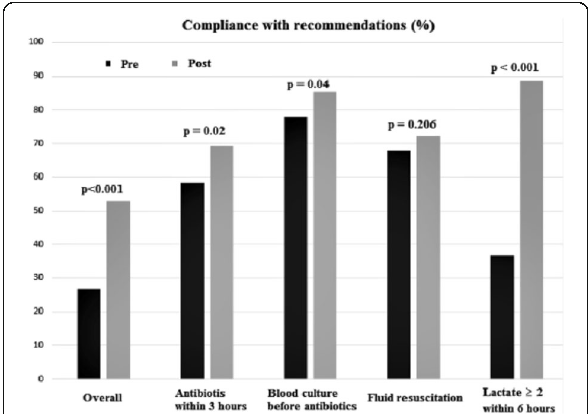
Fig. 2 (abstract P13). Compliance with recommendations before and after implementation of intelligent sepsis management system among patients with sepsis and septic shock